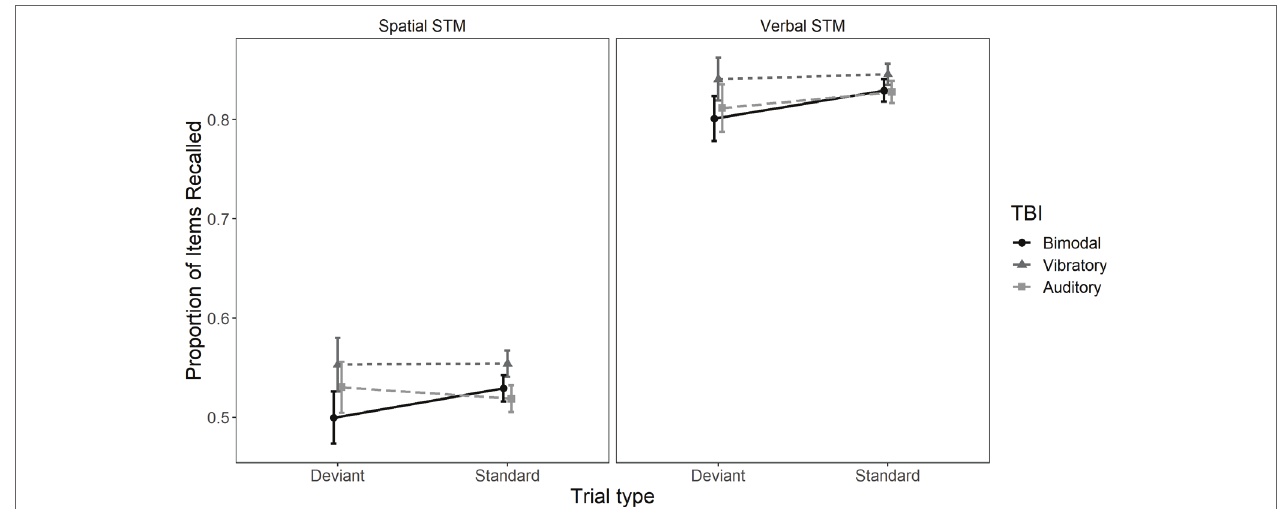
FIGURE 2 | Mean proportion of items correctly recalled in trials with and without a spatial deviant. The left panel is depicting proportion of correctly recalled items in the spatial task and the right panel proportion of correctly recalled items in the verbal task. Error bars represent 95% confidence